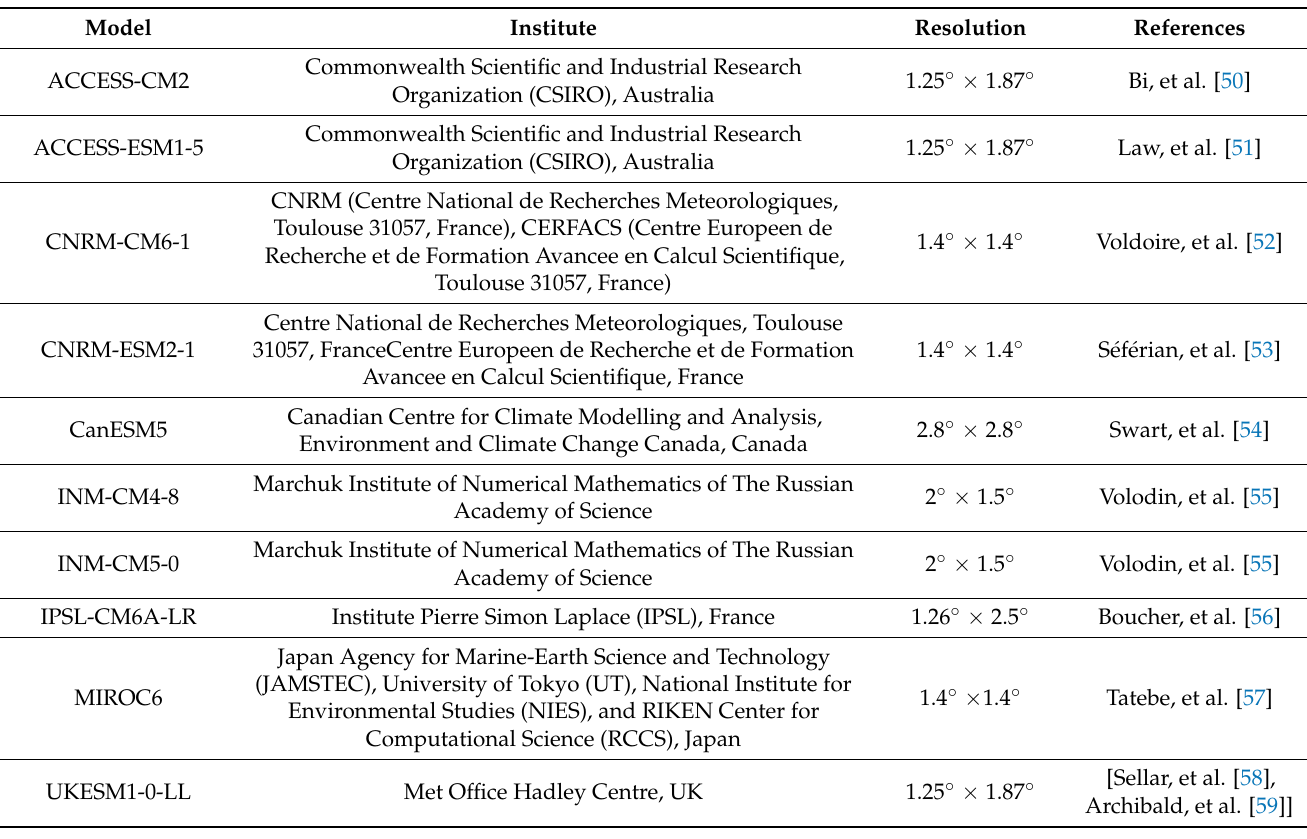
Table 2. Detailed information of selected